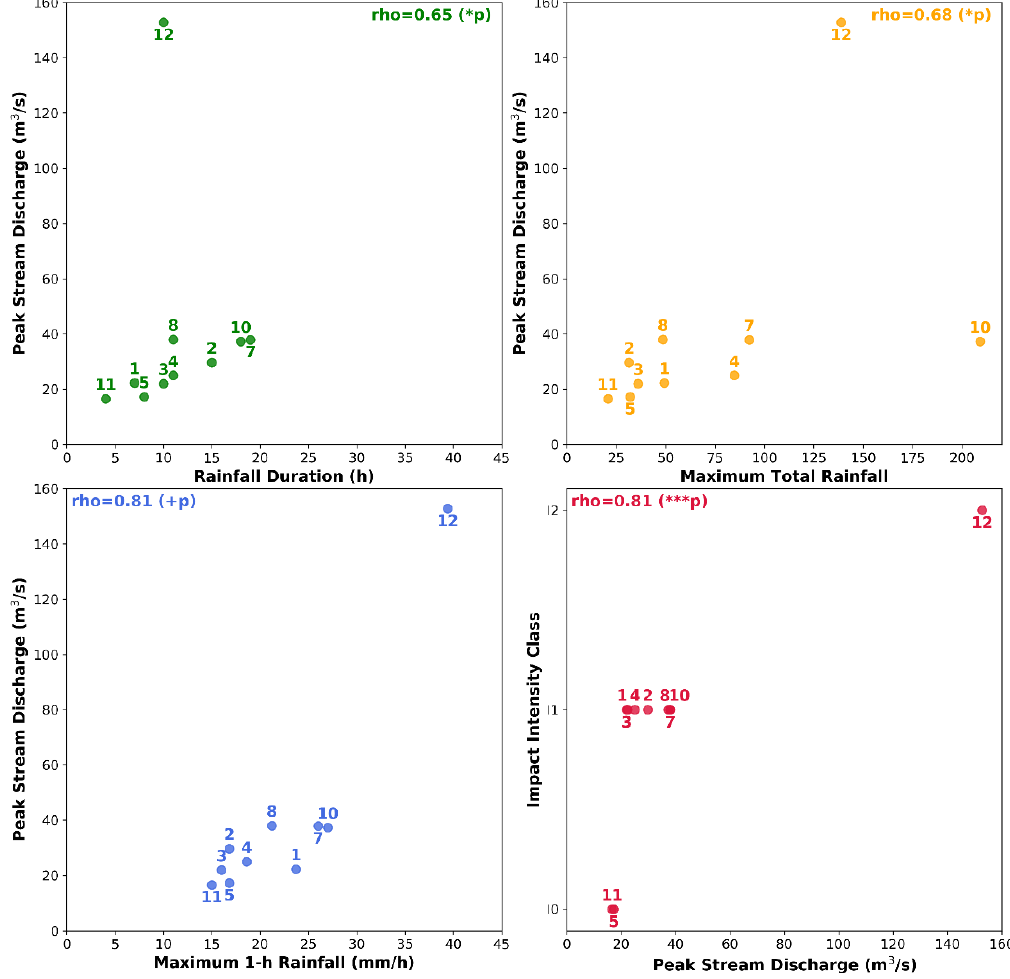
Figure A1. As in Figure 2 but without considering the events #6 and #9 in the analysis. The numbers indicate the events IDs (Table 3), while rho values indicate the Spearman correlation coefficient, with statistical significance, p value, being symbolized as: + p (>0.05; not significant), * p (≤0.05; 95% confidence interval), ** p (<0.01; 99%confidence interval) and *** p (<0.001; 99.9% confidence interval).